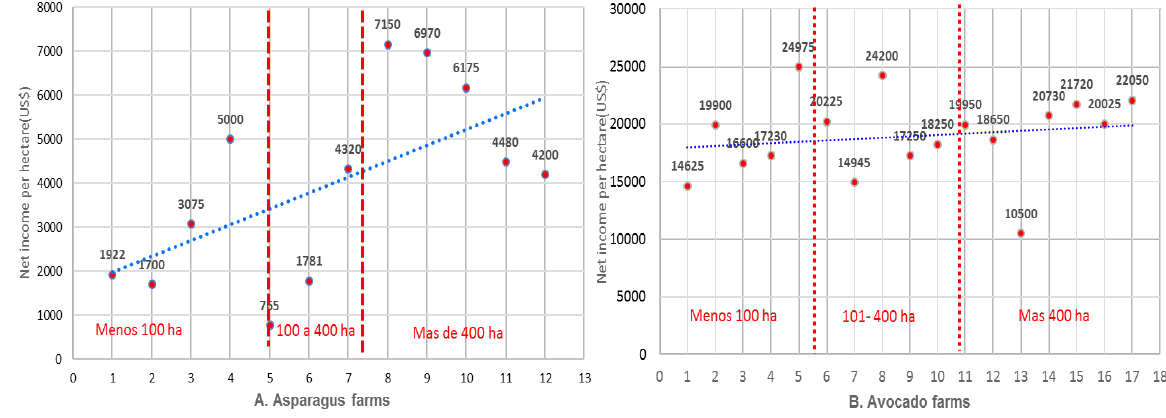
Figure 11. Net income per hectare per year from the asparagus and avocado farms in 2017. (A, B) Net income from the asparagus farms (A) and avocado farms